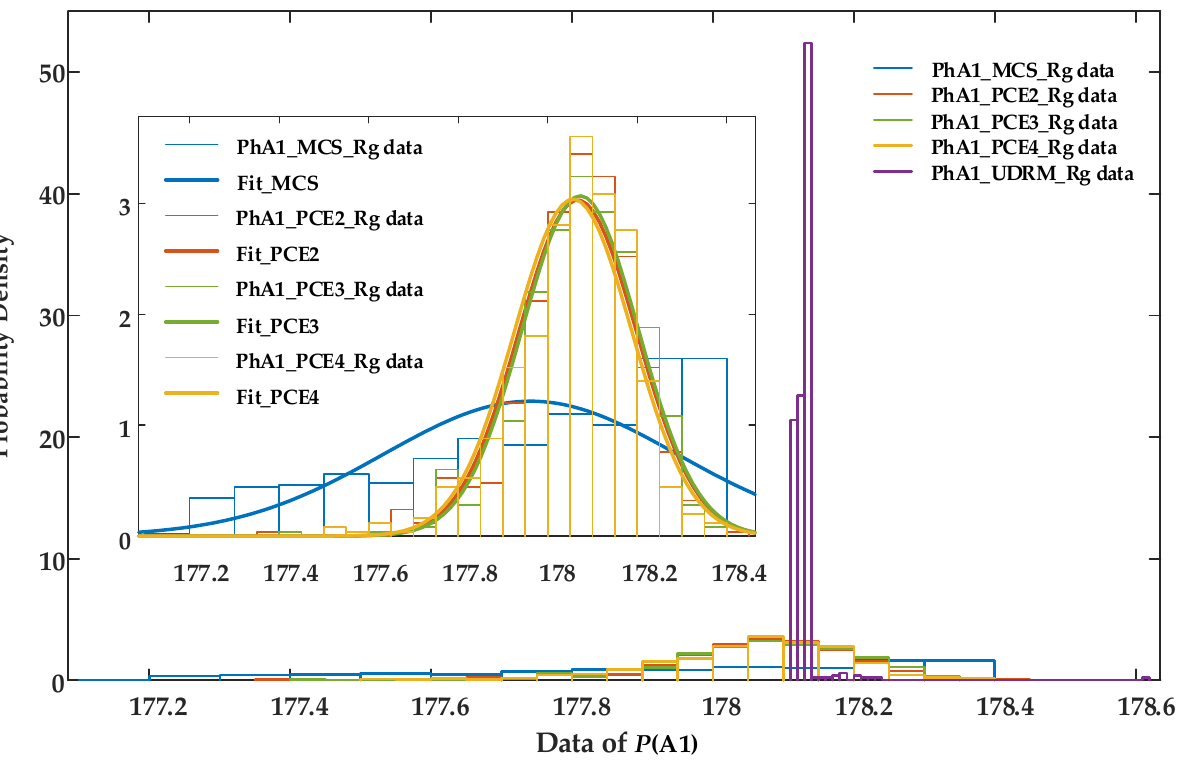
Figure 11. The probability density of the calculated data of P (A1) using the 5 different methods under 50% uncertainty of grounding resistance under short-circuit fault condition.